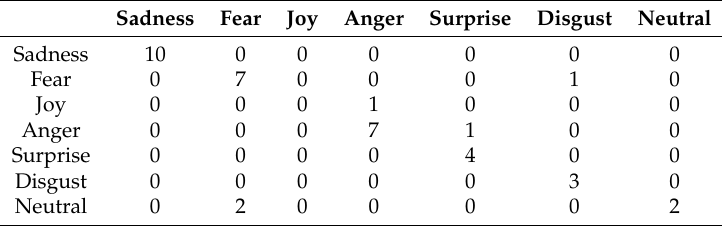
Table A21. A4 actor confusion matrix from the Emo-DB in the third phase.